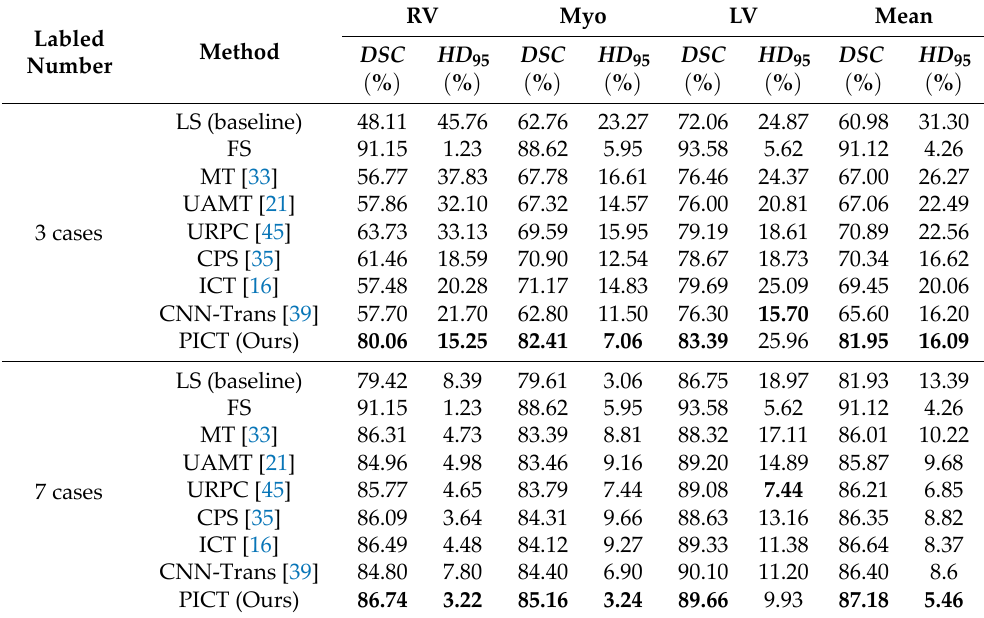
Table 4. Quantitative comparison results of mean DSC score and HD 95 of the state‑of‑art method on ACDC under 3 labeled cases and 7 labeled cases. The bold fonts indicate the best results of the comparing